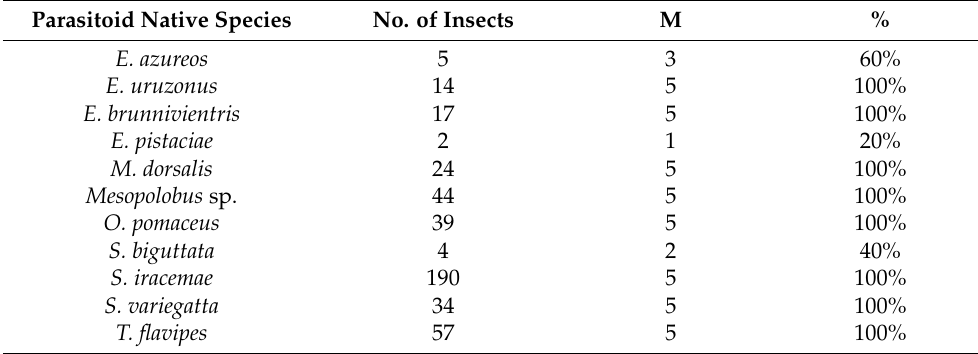
Table 8. Abundance and relative frequency of native species of parasitoids identified in 2018 in chestnut orchards located in Arcos de Valdevez and Ponte de Lima, with different treatments of T. sinensis . Parasitoid Native Species No. of Insects